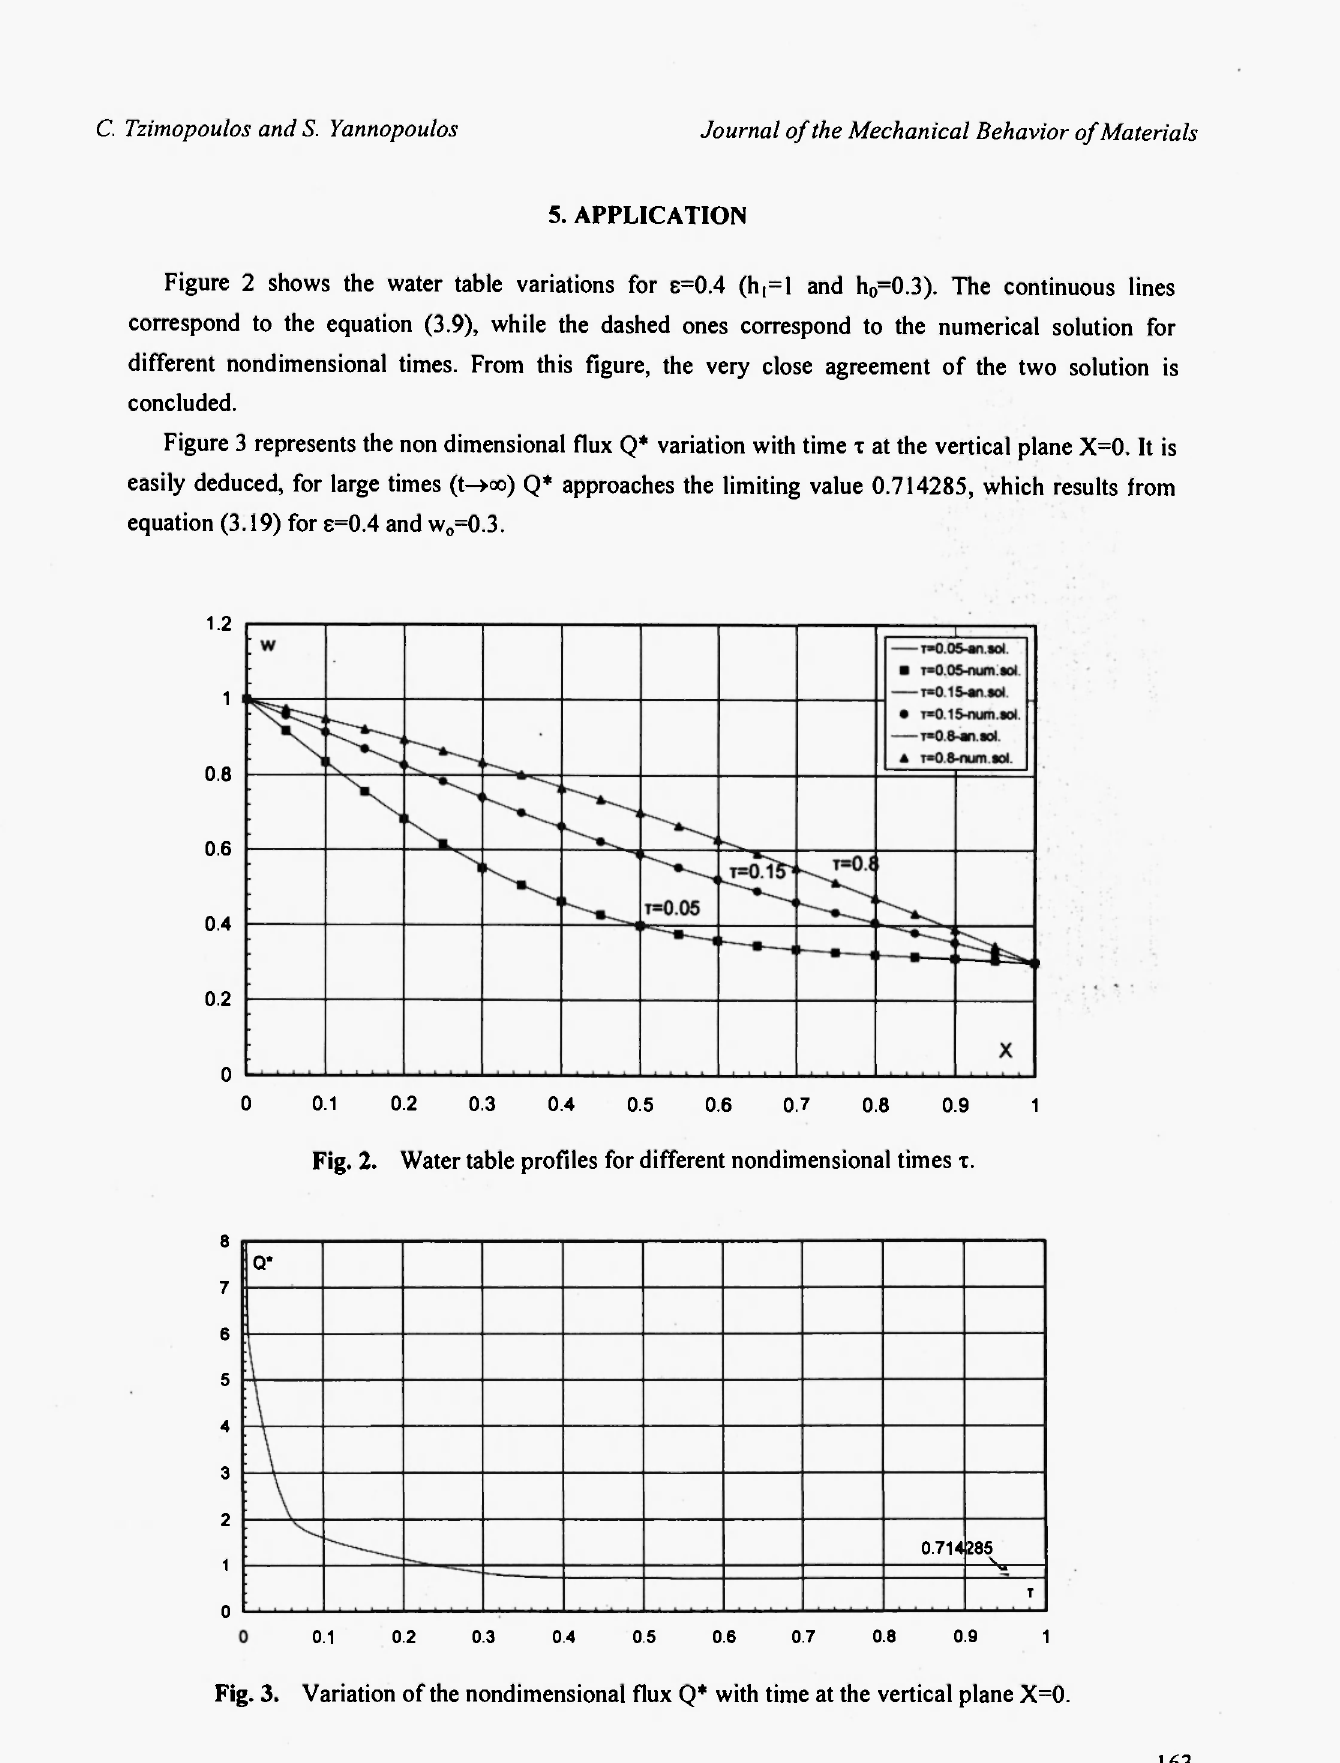
Fig. 3. Variation of the nondimensional flux Q* with time at the vertical plane